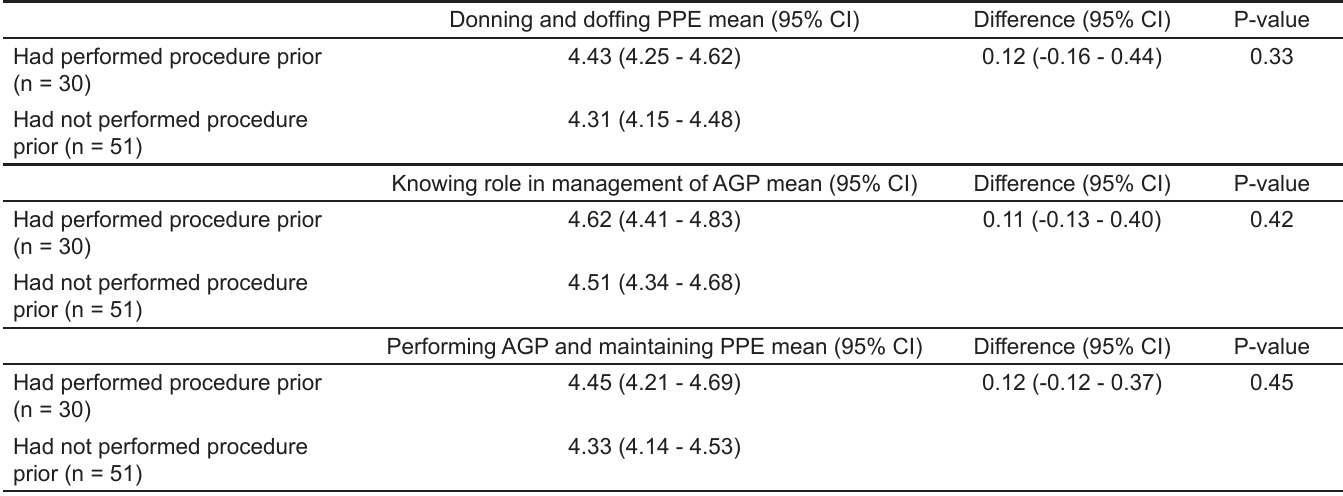
AGP, aerosol-generating procedure; PPE, personal protective equipment; CI, confidence